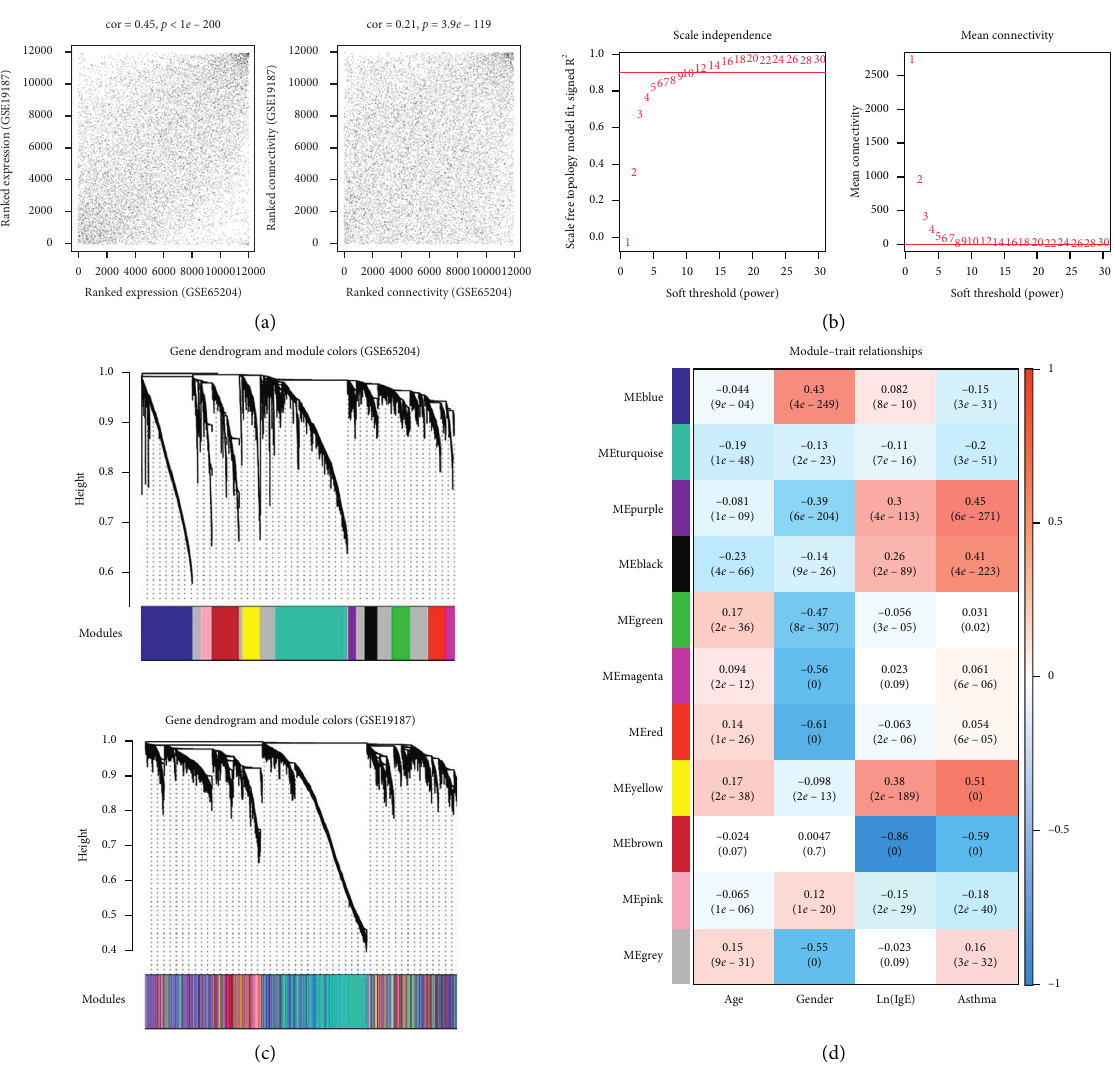
Figure 2: Screen of significantly stable modules related to asthma in children by weighted gene coexpression network analysis (WGCNA). (a) The correlation of gene expression levels (left) and network connections (right) between the training set (GSE65204) and the validation set (GSE19187). (b) Left: adjacency matrix weight parameter power selection graph. The red line represents the standard line where the square value of the correlation coefficient reaches 0.9. Right: schematic diagram of the average connectivity of DE-mRNAs under different power parameters. The red line represents the value of the average degree of the coexpression network ( � 1) under the value of the weight parameter power of the adjacency matrix in the left. (c) The module classification trees of genes in GSE65204 (above) and GSE19187 (below). Each color represents a different module. (d) The heat map of correlations between clinical information of samples and each module obtained from the training